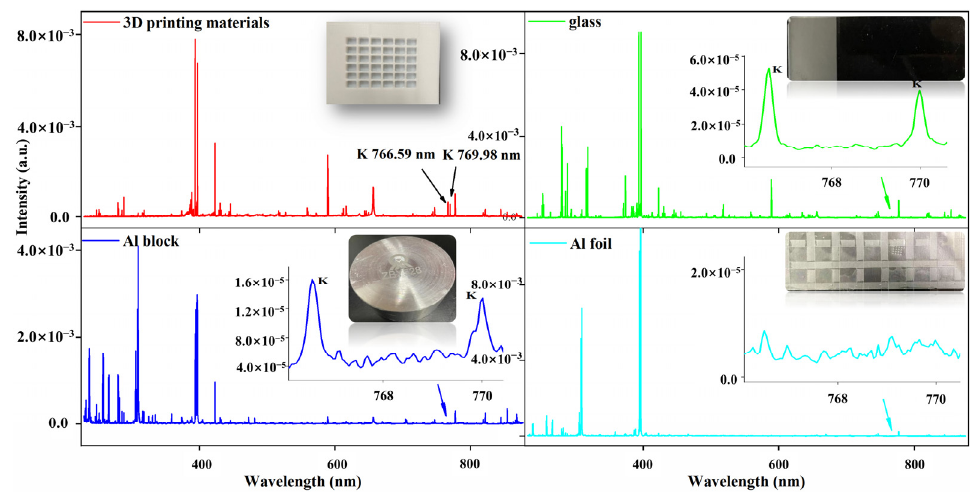
Figure 1. LIBS spectra and actual pictures of four different materials, including 3D printing materials, glass, Al block and Al foil.